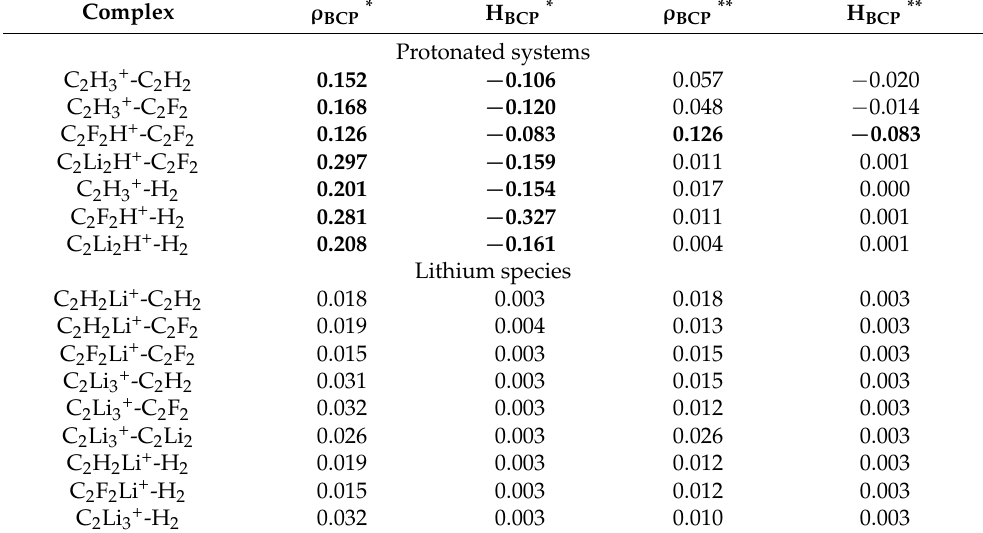
Table 4. The selected QTAIM parameters (in au), the electron density at BCP, ρ BCP , and the total elec- tron energy density at BCP, H BCP , are given; the bold values correspond to interactions characterized by negative ∇ 2 ρ BCP values. One asterisk ( * ) corresponds to stronger interactions, two asterisks ( ** ) correspond to weaker interactions. Complex ρ BCP * H BCP * ρ BCP ** H BCP ** Protonated systems C 2 H 3+ -C 2 H